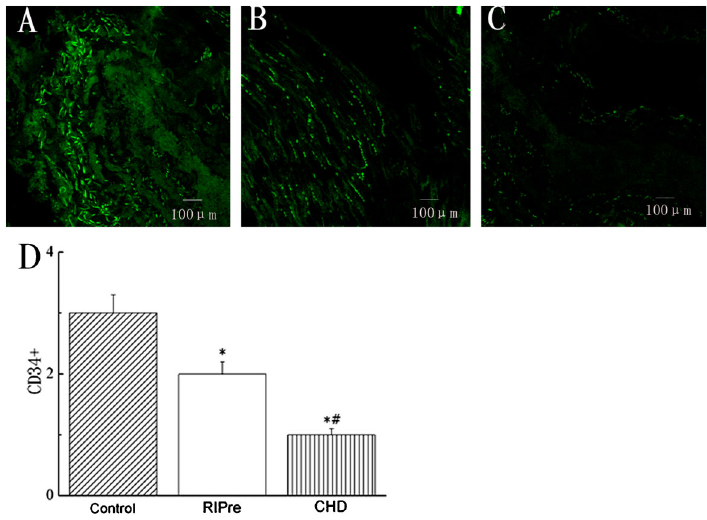
Figure 4. Representative micrographs of immu- nofluorescence staining of arterial CD34 + cells in the A , control group; B , remote ischemic pre- conditioning (RIPre) group; and C , coronary heart disease (CHD) group. Cells expressing hemato- poietic progenitor cell antigen CD34 (CD34 + ) were significantly reduced in the CHD group compared with the control group but were significantly increased by RIPre (P , 0.05). D , Relative fluorescence of EPC staining of endothelial progenitor cells (EPCs); CD34 + staining. Data are reported as means±SE for n=20 in each group. *P , 0.05 vs control group; # P , 0.05 vs RIPre group (Student-Newman- Keuls test). Note that the example does not exactly reflect the mean value of all